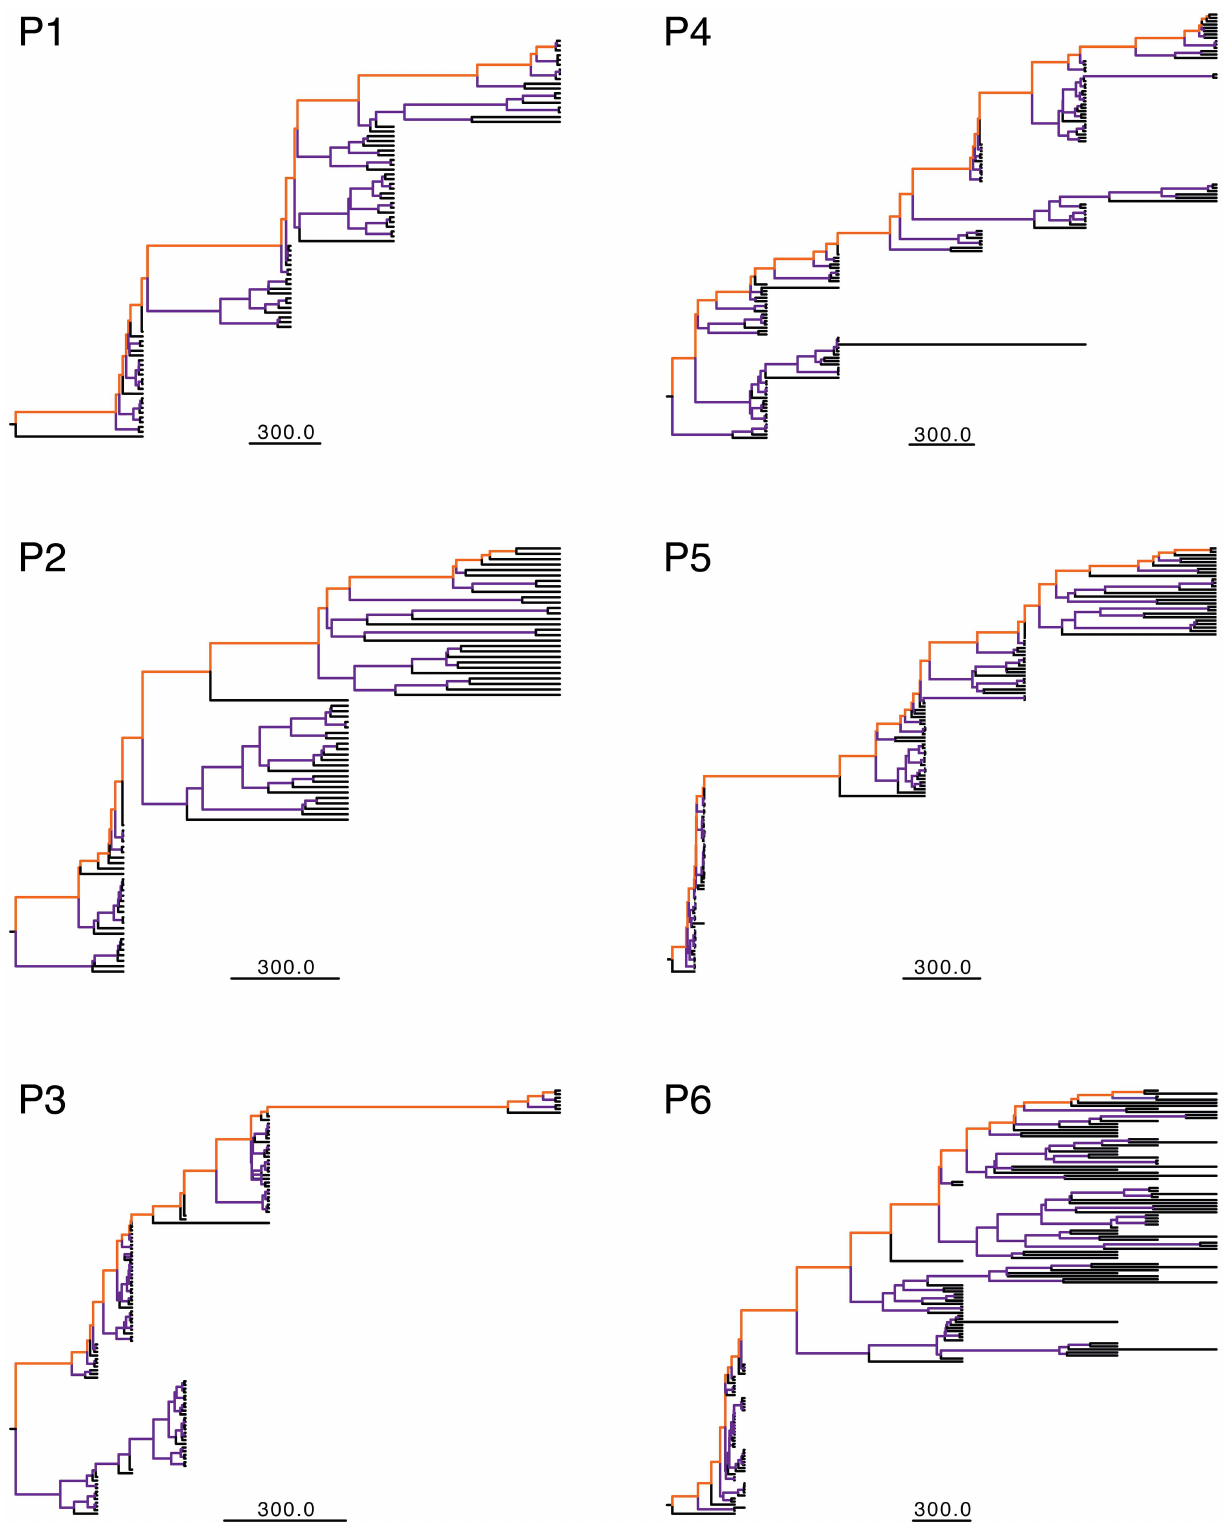
Figure 1. HIV-1 gag p24 genealogies for all six HLA-B*5701 subjects displaying different branch sets. Internal and external branches are shown for each subject (P1-P6), colored in purple and black, respectively. Orange branches indicate one of the possible backbone paths in the genealogy (see Methods). Specific estimates were based on 200 randomly sampled trees from the posterior distribution obtained with a Bayesian coalescent framework enforcing a relaxed molecular clock. Branch lengths are drawn proportional to the time scale (in days) at the bottom of each tree.